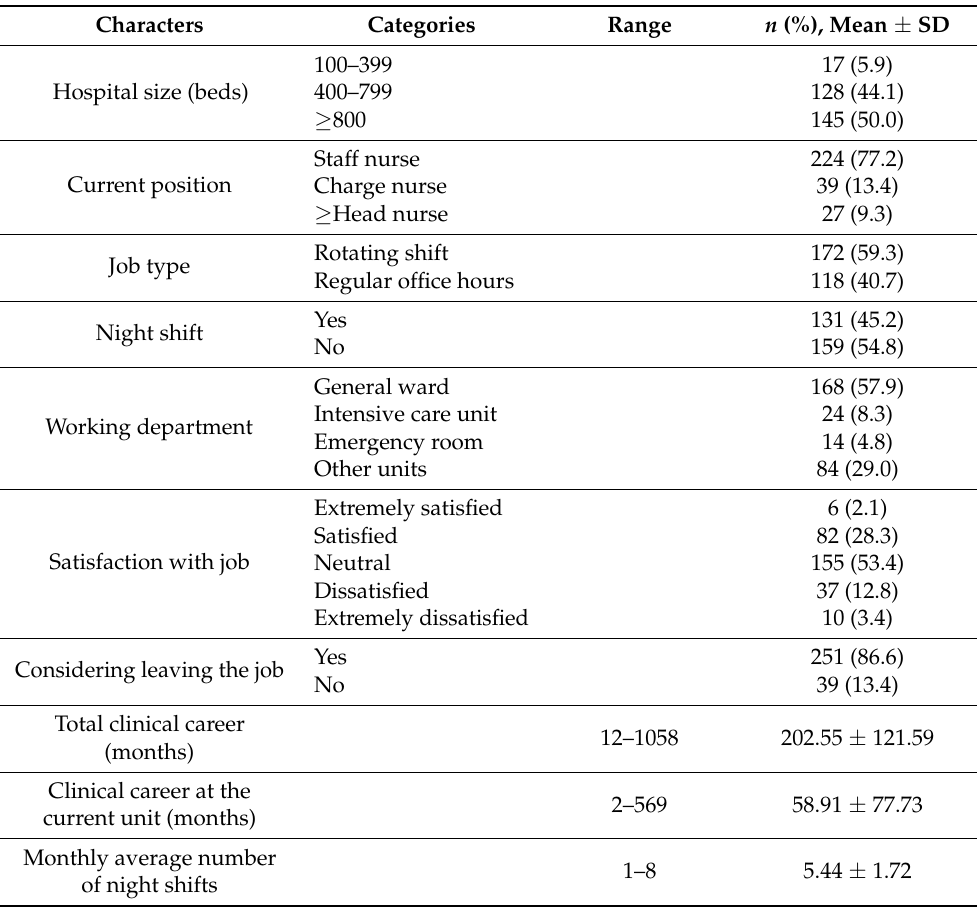
Table 2. Participants’ work-related characteristics ( n = 290).